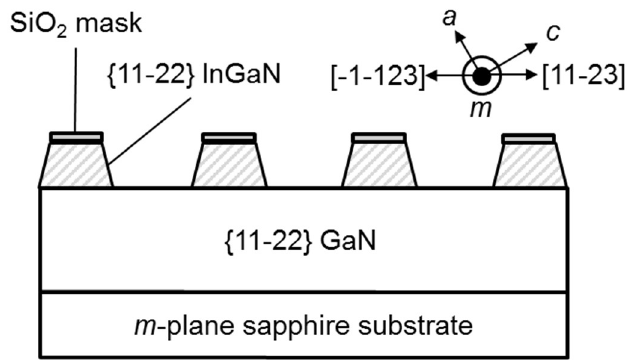
Figure 5. A schematic illustration of the trench-patterned {11-22} InGaN template with a SiO 2 mask on the terraces. on the